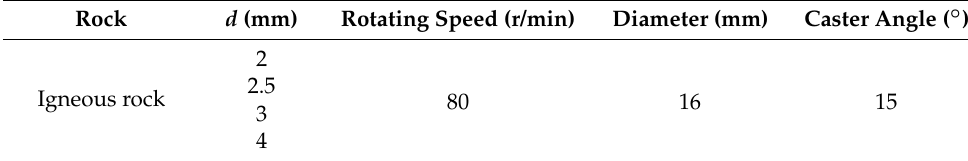
Table 3. Numerical simulation experiment scheme of cutter breaking rock.